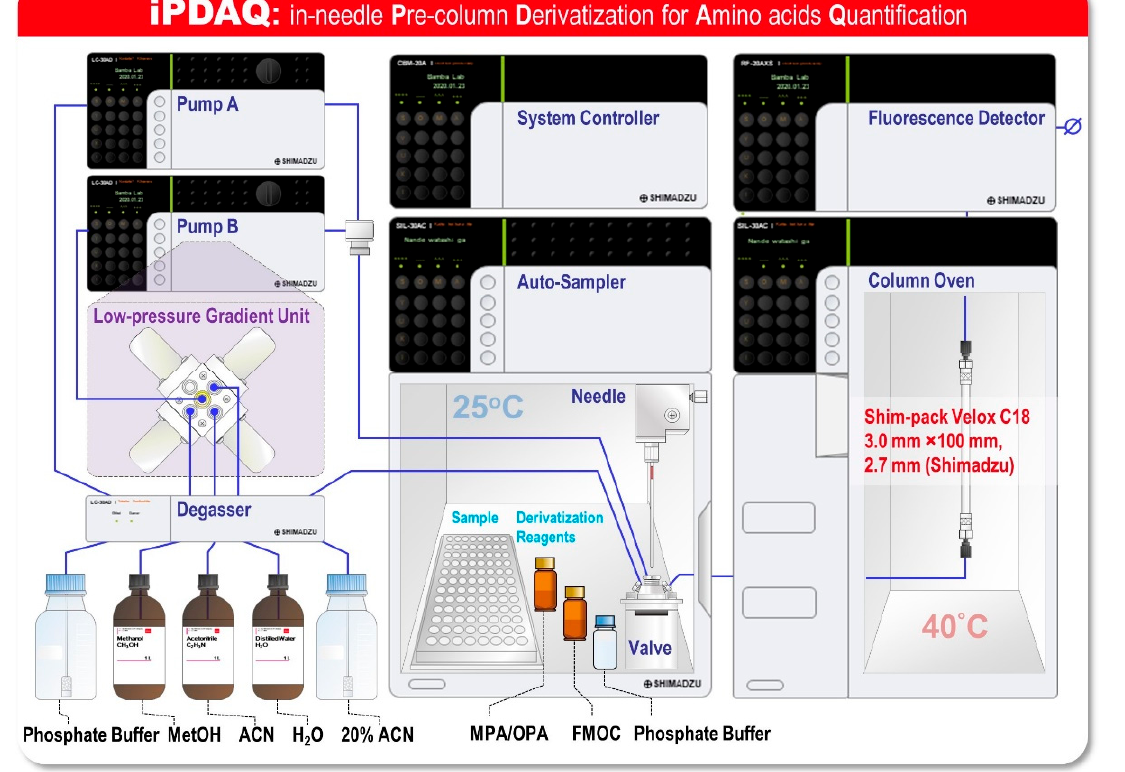
Figure 1. Schematic of the system configuration of an in-needle Pre-column Derivatization system for Amino acid Quantification (iPDAQ). The diagram shows an HPLC system for amino acid quan- tification based on the method of the fast pre-column derivatization of amino acids, which facilitates the automated pre-column derivatization of amino acids using an autosampler.